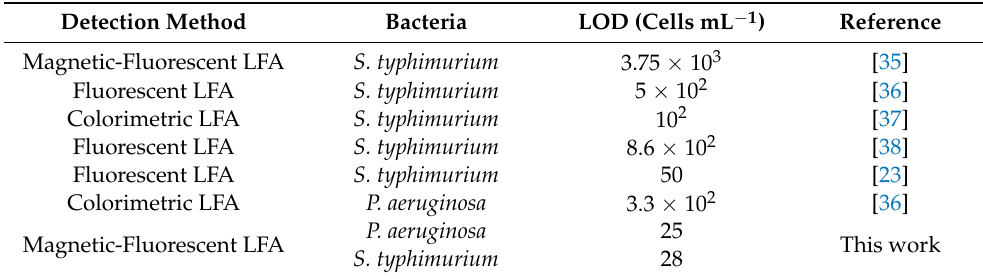
Figure 3. ( a ) Photograph and ( b ) fluorescence images, and ( c ) heat map of corresponding test line intensities for P. aeruginosa and S. typhimurium . ( d ) Standard plate counting method for the quantitative determination of P. aeruginosa ( I ) and S. typhimurium ( II ). ( e ) Corresponding test line intensities of Mag@QDs-WGA-LFA for P. aeruginosa and S. typhimurium . Relationships of fluorescence intensities from test lines with the concentrations of P. aeruginosa ( f ) and S. typhimurium ( g ). Table 1. Comparison of Mag@QDs-WGA-LFA with other recently reported LFA-based bacterial detection